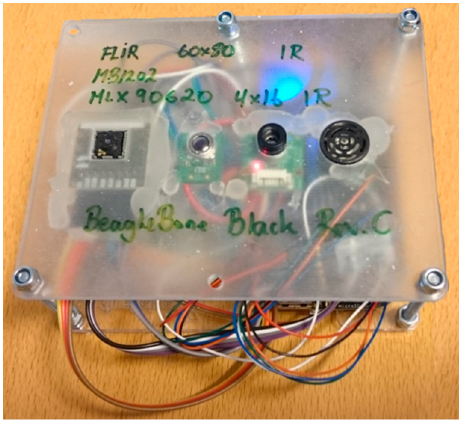
Figure 1. Experimental setup.